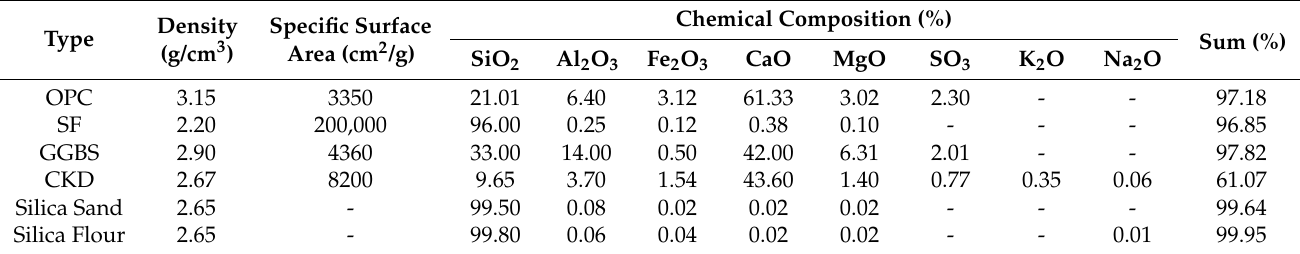
Table 1. Chemical compositions and physical properties of materials.